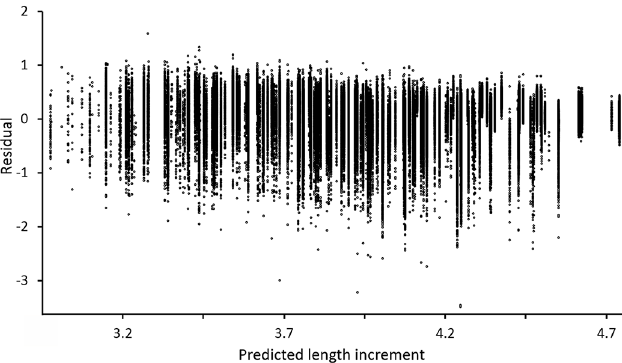
Fig. 3. Residuals from growth model in relation to predicted length increments (mm TL;